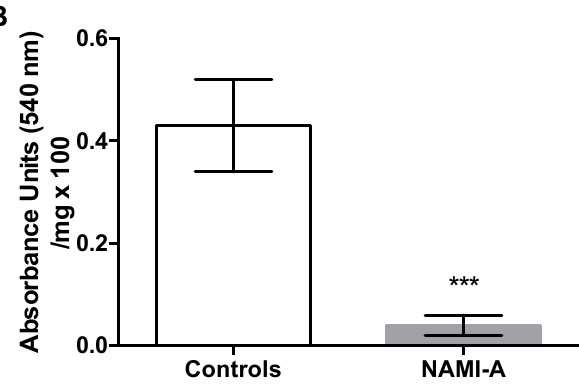
Figure 11. Anti-angiogenic activity of NAMI-A in the model of Matrigel ™ pellets. The Matrigel ™ pellets containing vascular endothelial growth factor (VEGF), heparin, TNF- α and phosphate buffered saline ( PBS) (controls), or 2 × 10 − 4 M NAMI-A (treated) were implanted subcutaneously (s.c.) in C57/BL 6N mice. After four days, the pellets were explanted, photographed ( A ) and the haemoglobin content measured with the method of Drabkin; ( B ) Data are the mean ± S.E.M. of three samples. Unpaired t -test: *** p < 0.001 vs. Controls.